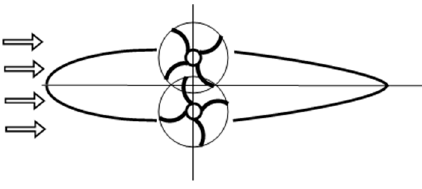
Figure 4. Twin rotor turbine concept.